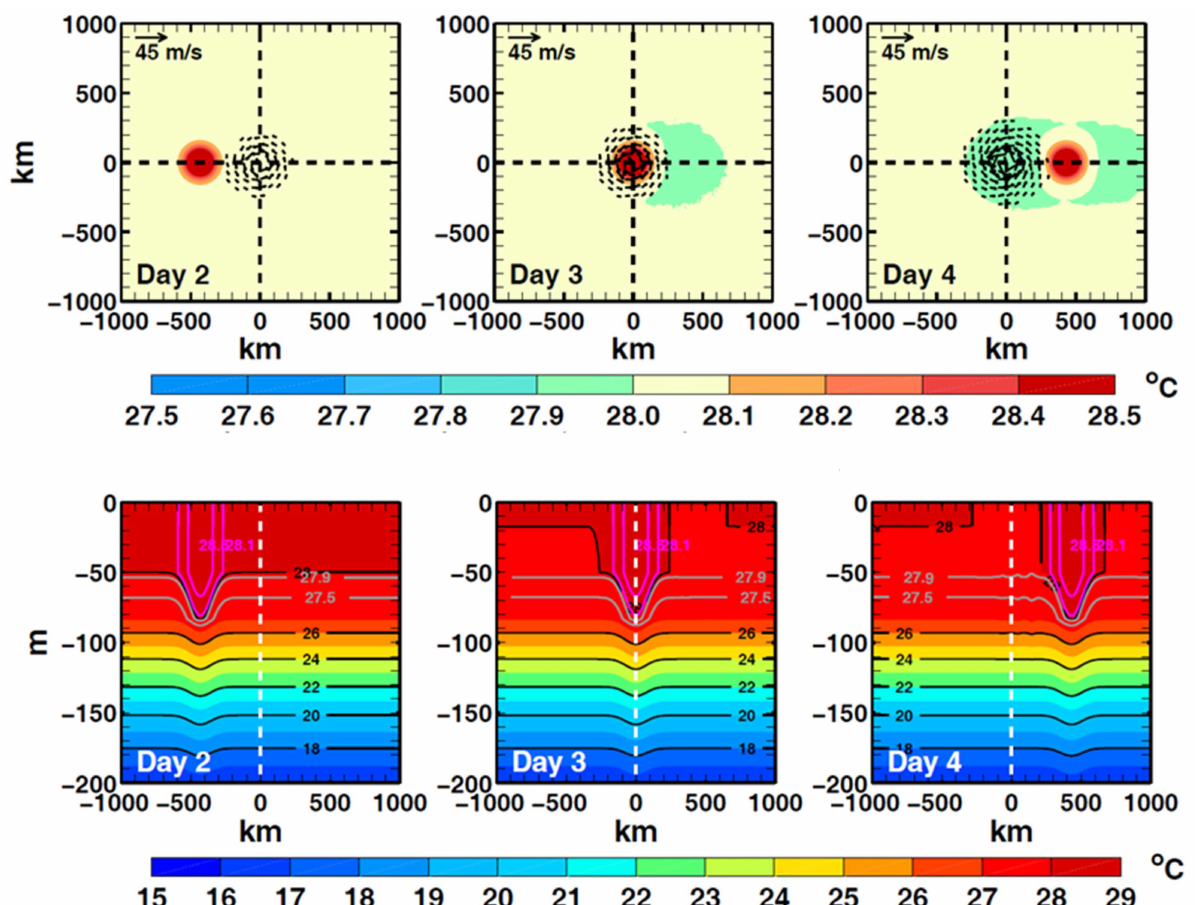
Figure 1. ( Top ) plan-view plots of 10-m wind (vectors; for clarity, vector length is the same for speeds >50 m/s, and vectors with speeds <25 m/s are not plotted) superimposed on SST (shading) at days 2, 3, and 4; and ( Bottom ) vertical xz -section plots of ocean temperature (shading with black contours 18, 20, 28 ◦ C, gray contours 27.5 and 27.9 ◦ C and magenta contours 28.1 and 28.5 ◦